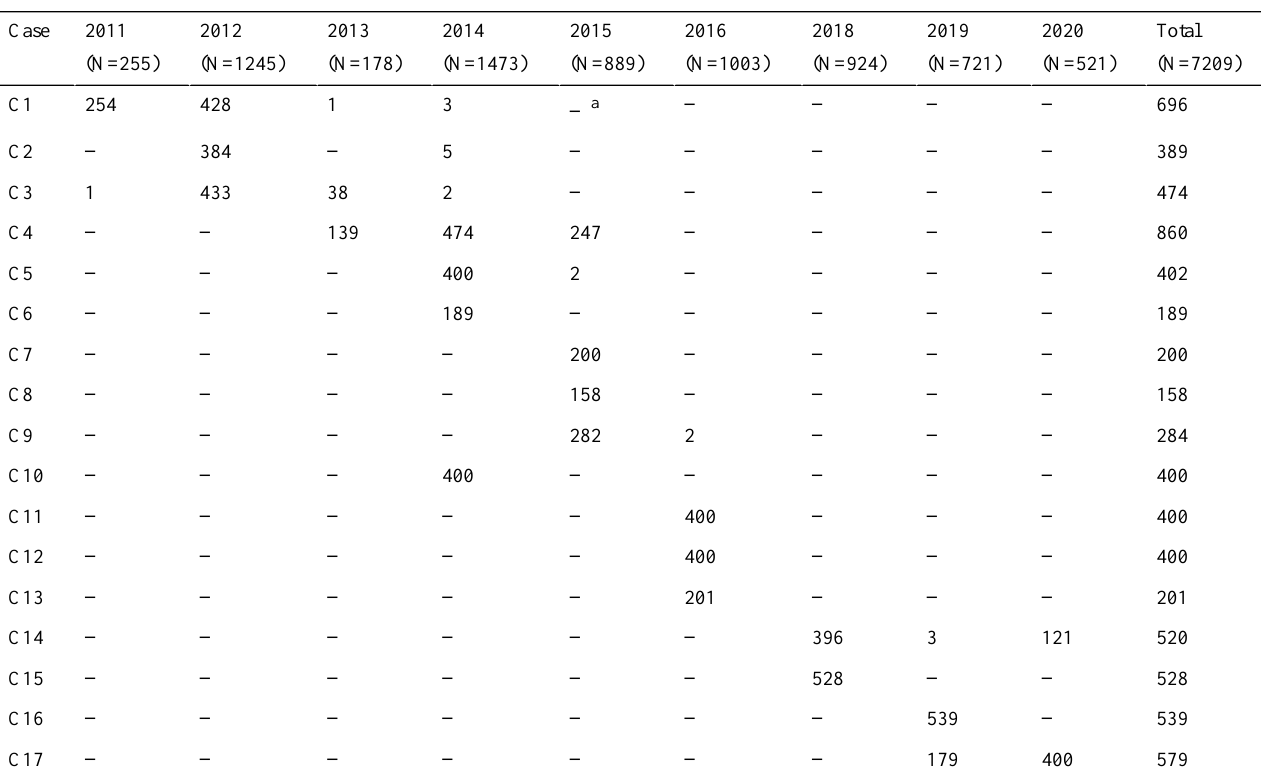
Table 2. Number of network reviews for all cases.